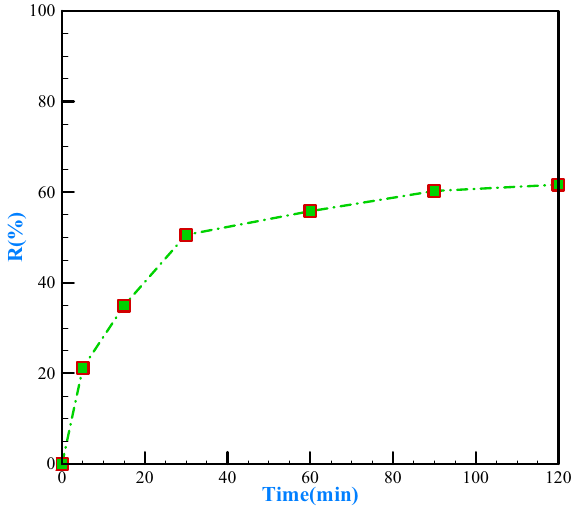
Figure 8. The effect of contact time on chromium removal.